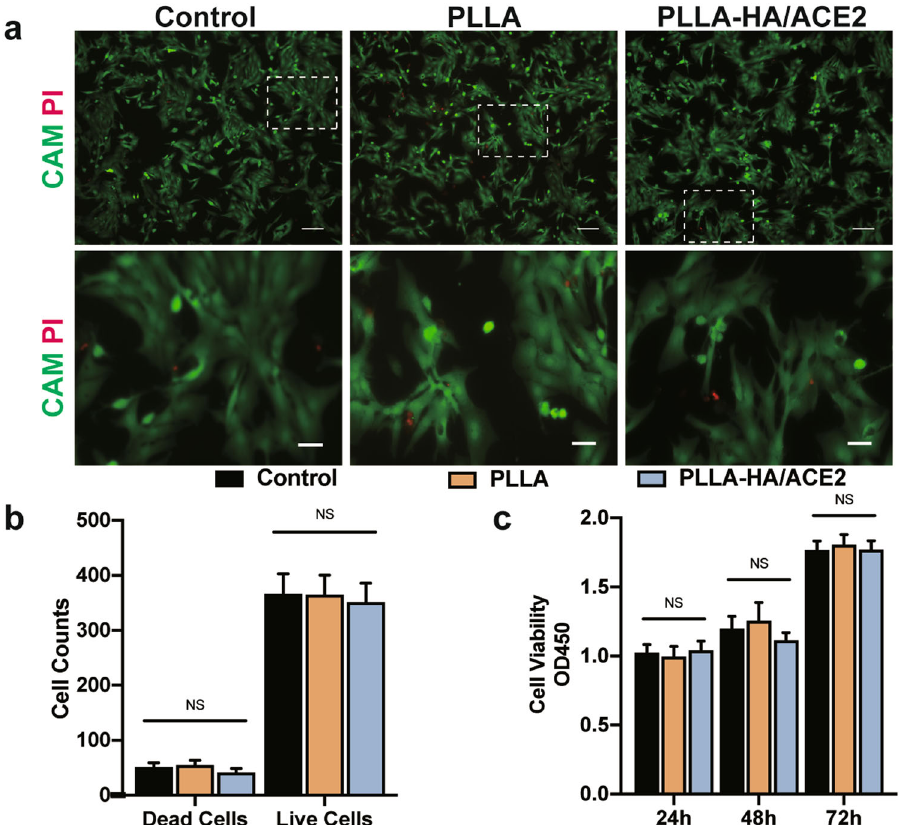
Fig. 3 Biocompatibility tests in vitro. a Representative live/dead fl uorescence stained by Calcein AM (green) and Propidium Iodide (red) at day 3. Scale bars represented 50 and 20 μ m for zoomed pictures. b Live and dead cell count per HPF of control, PLLA, PLLA-HA/ACE2 groups. n = 4/group. c CCK-8 cell viability quanti fi cation results in different groups after 1, 2, or 3 days. n = 4/group. Data were represented as the mean ± SEM and analyzed for statistical signi fi cance using One-way ANOVA followed by Tukey ’ s multiple comparison test; NS no signi fi cant